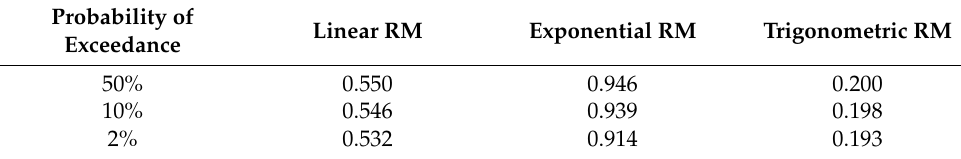
Table 5. Resilience exponential LM (for the selected probability of